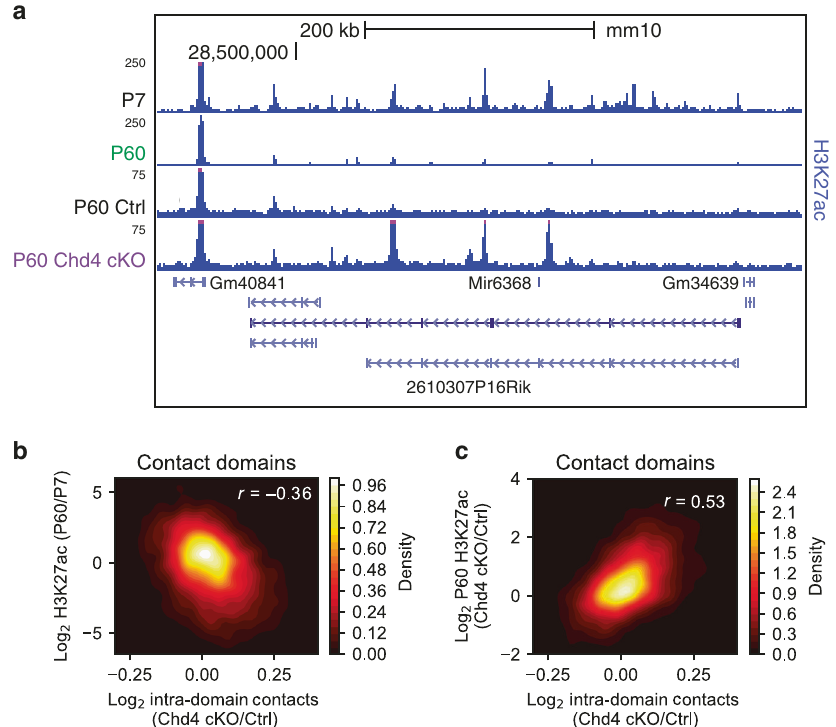
Fig. 5 Chd4 loss impairs the maturation of epigenomic features in contact domains. a Genome-browser snapshot of a contact domain on chromosome 13 as in Fig. 2a displaying the ChIP-seq pro fi les of H3K27ac in the P7 and P60 cerebellum. Also displayed is the ChIP-seq pro fi le of H3K27ac in the cerebellum of control and Chd4 cKO mice at P60. Blue denotes the extent of the contact domain. b , c Density plot comparing the change in Hi-C contacts within a domain with the ( b ) change in H3K27ac in the cerebellum between P7 and P60 and ( c ) change in H3K27ac in the cerebellum of control and Chd4 cKO mice at P60. Pearson ’ s r , p <